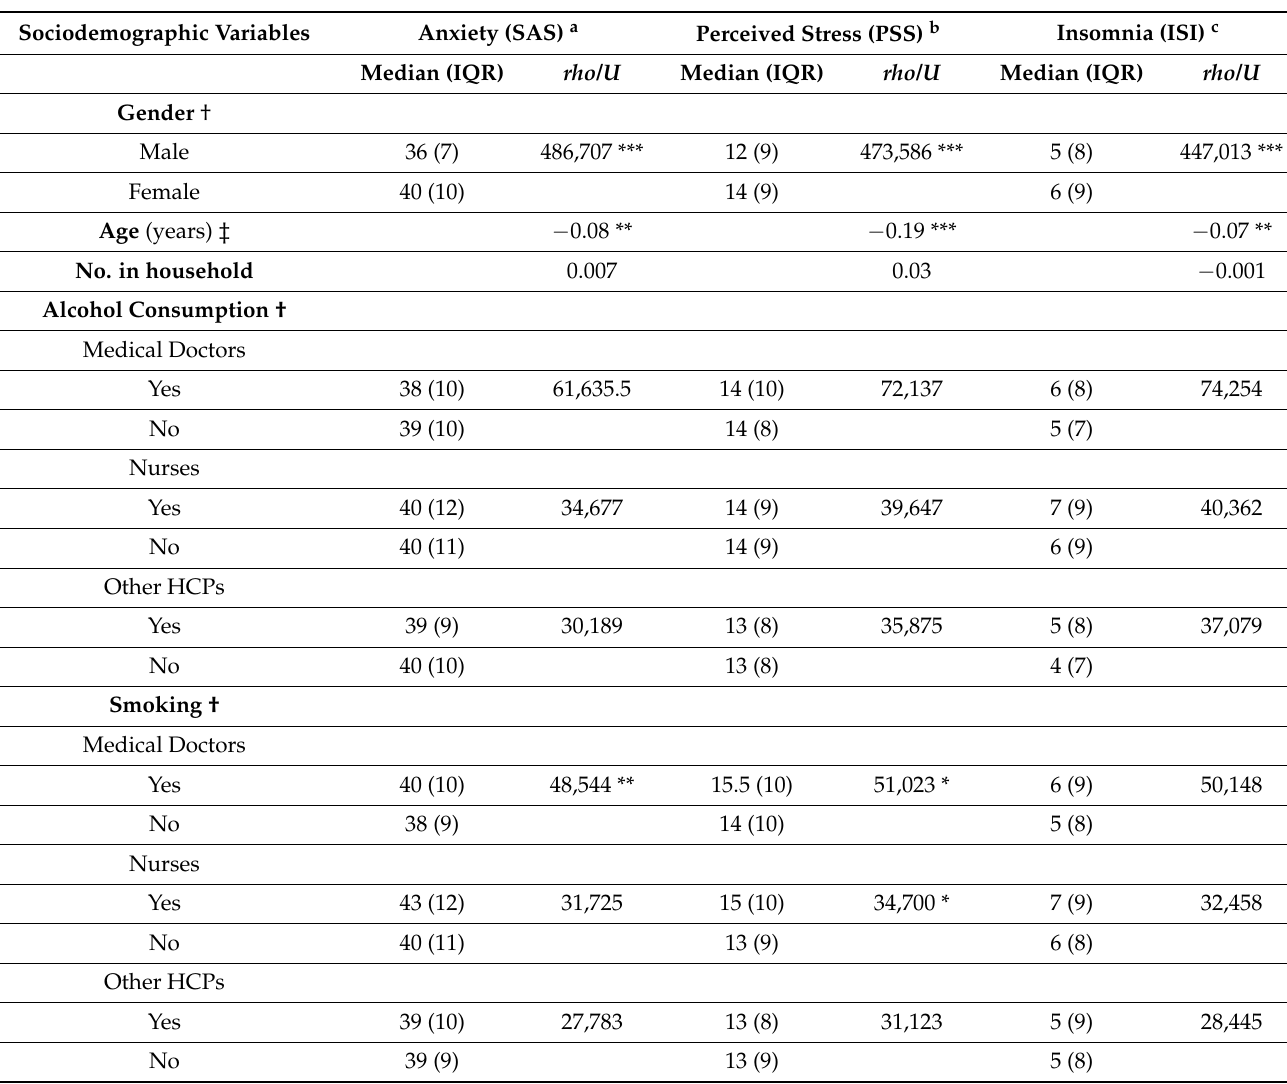
Before the 11 March n (%)